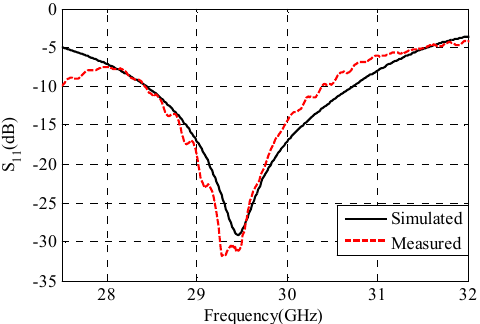
Figure 13. Measured and simulated reflection coefficients versus frequency.